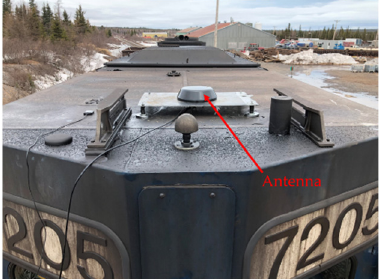
Figure 21. Antenna attached to the locomotive roof.